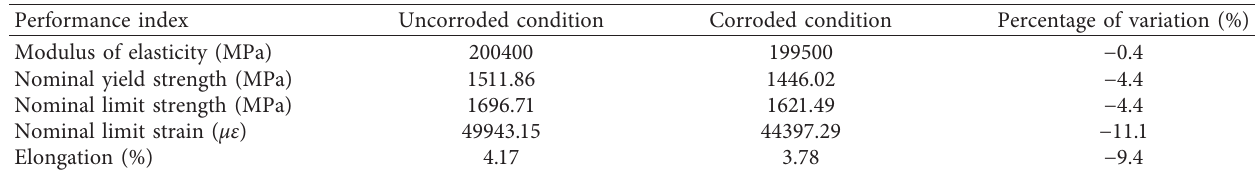
Table 1: Laboratory test on the basic mechanical performance of parallel wires in Yonghe Bridge.